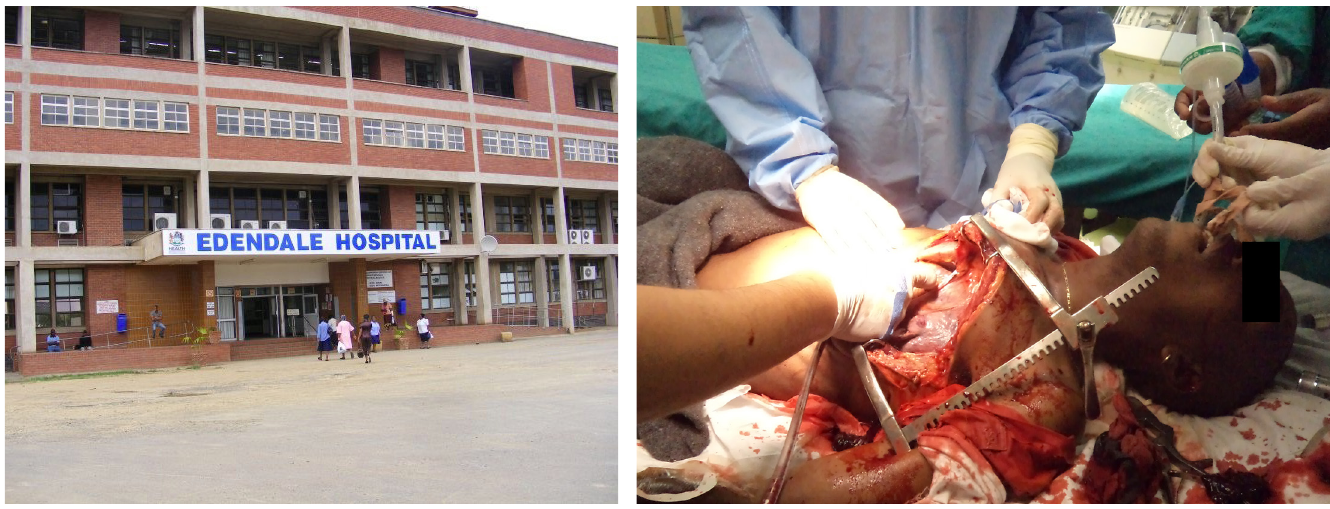
Figure 2. Entrance - Edendale Hospital. Figure 3. Emergency room thoracotomy for penetrating cardiac injury, traumatic arrest on